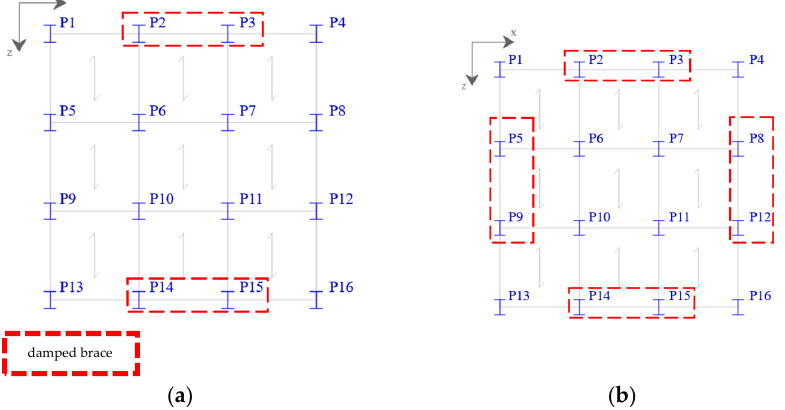
Figure 10. Plan layout of damped braces in ( a ) two-story and four-story structures, ( b ) eight-story structure. Table 4. Two-story MRF: elastic stiffness 𝐾 (cid:3052)(cid:3036)(cid:3005) and yield force 𝑁 (cid:3052)(cid:3036)(cid:3005) of the dampers at each story in X-direction for µ DB = 4 and µ DB = 10.